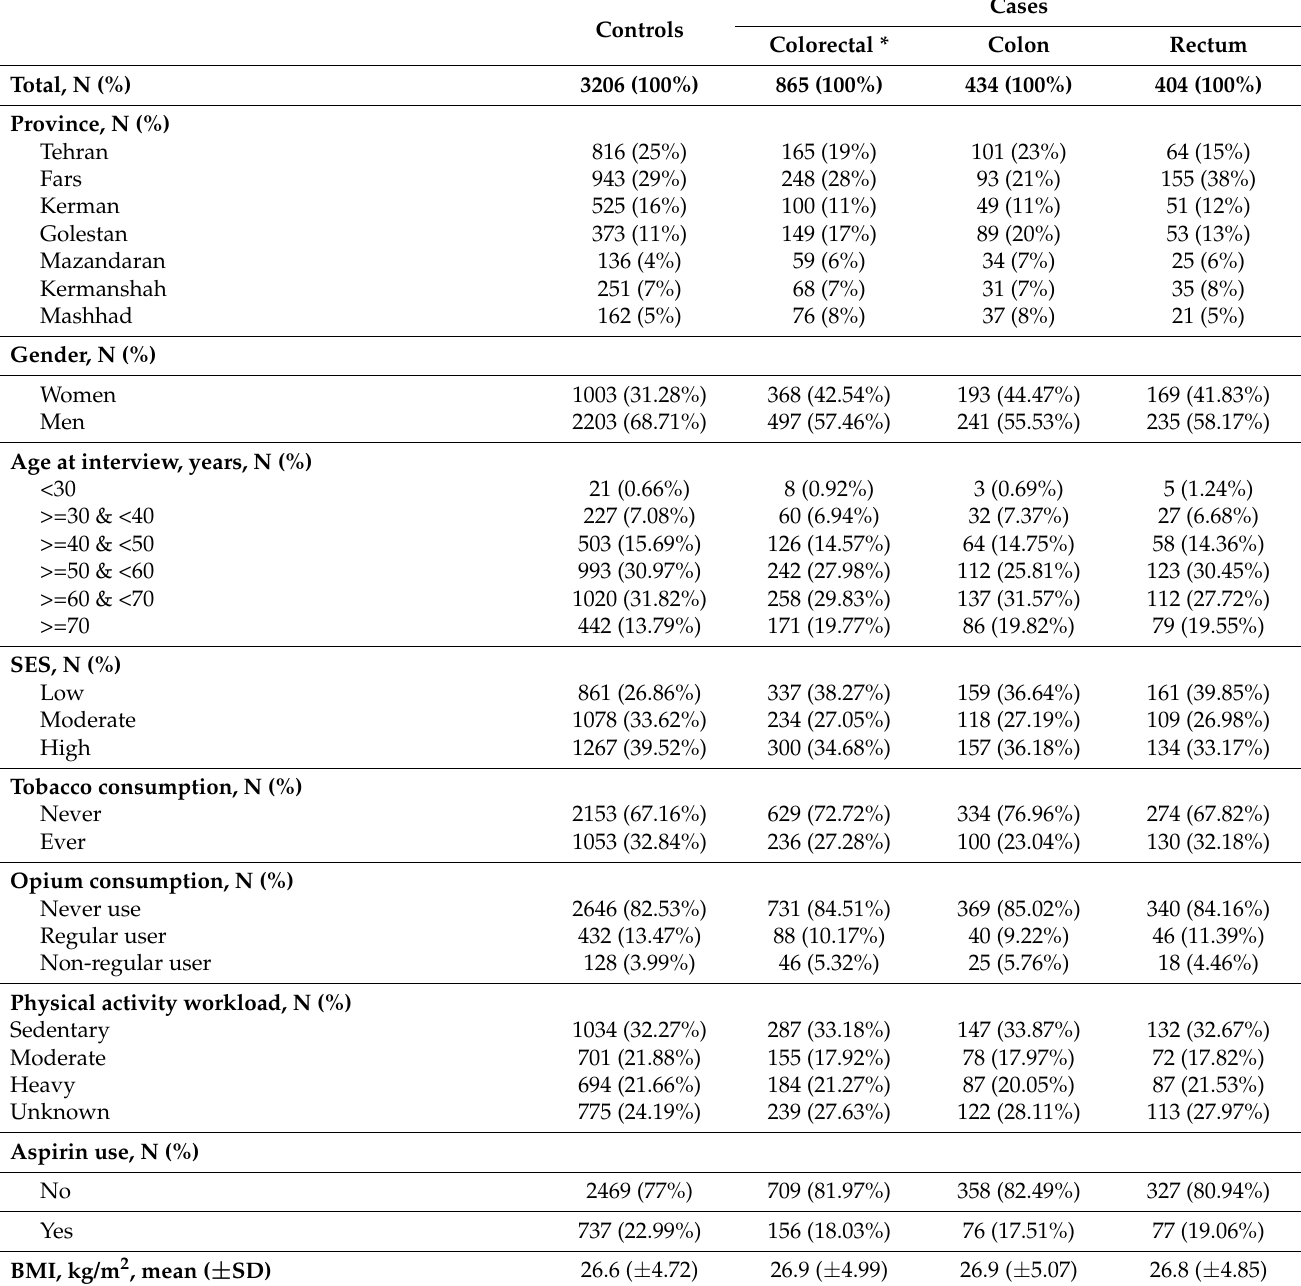
Table 1. Selected baseline demographic and lifestyle characteristics of study participants by colorectal cancer status, IROPICAN